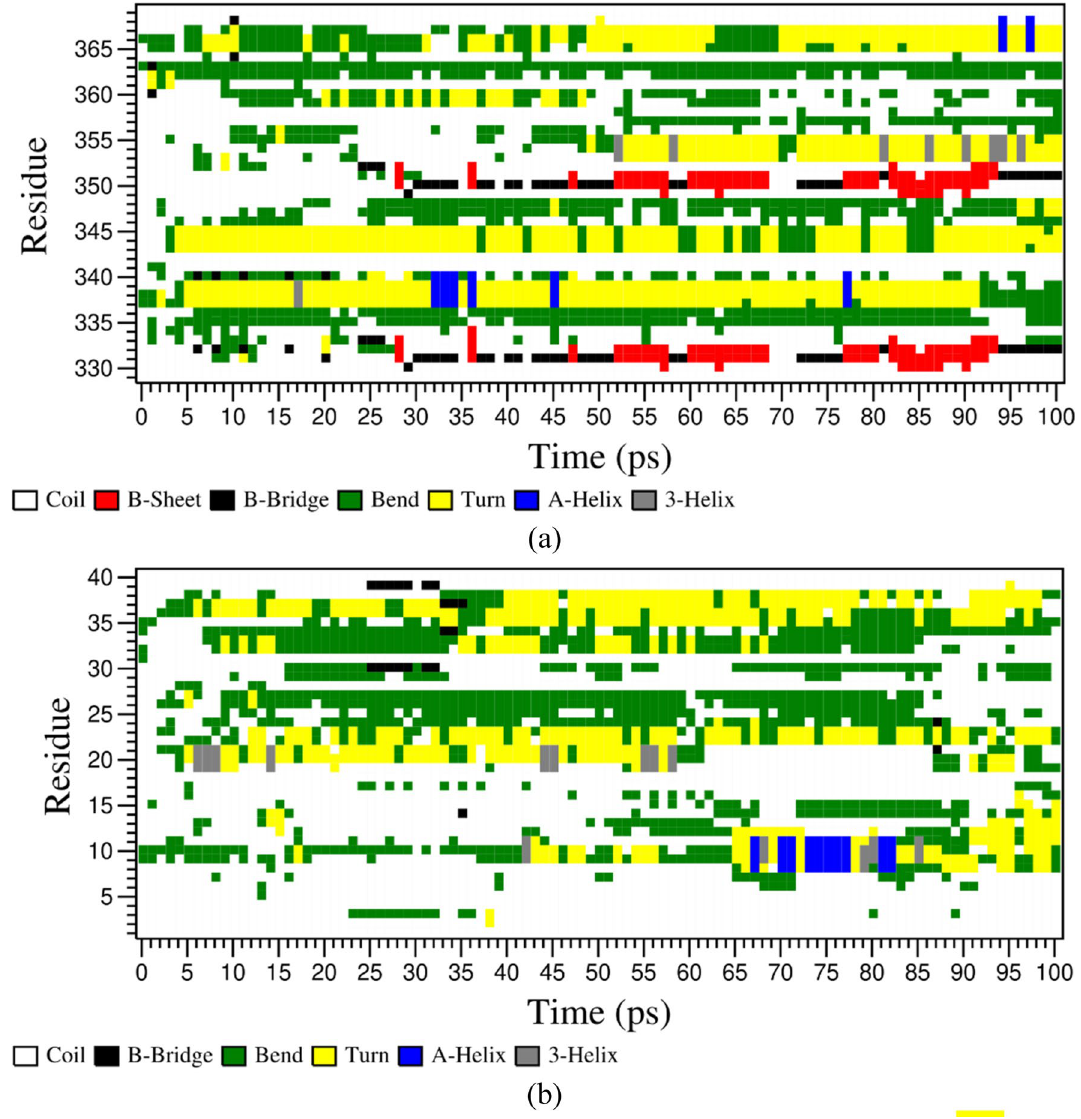
Figure 12. Change in secondary structure elements of SSTR2 C-terminal in the presence ( a ) and in the absence ( b ) of DPPC bilayer over simulation time. The domain formed more β-sheets in presence of lipid molecules during the